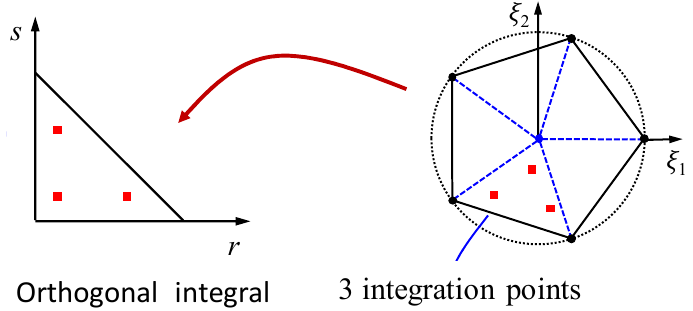
Figure 7. Standard quadrature rules.